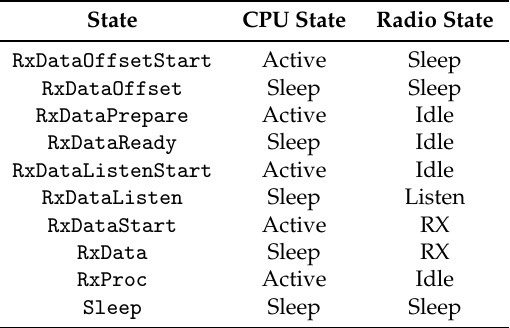
Table 4. States in a RxData slot.